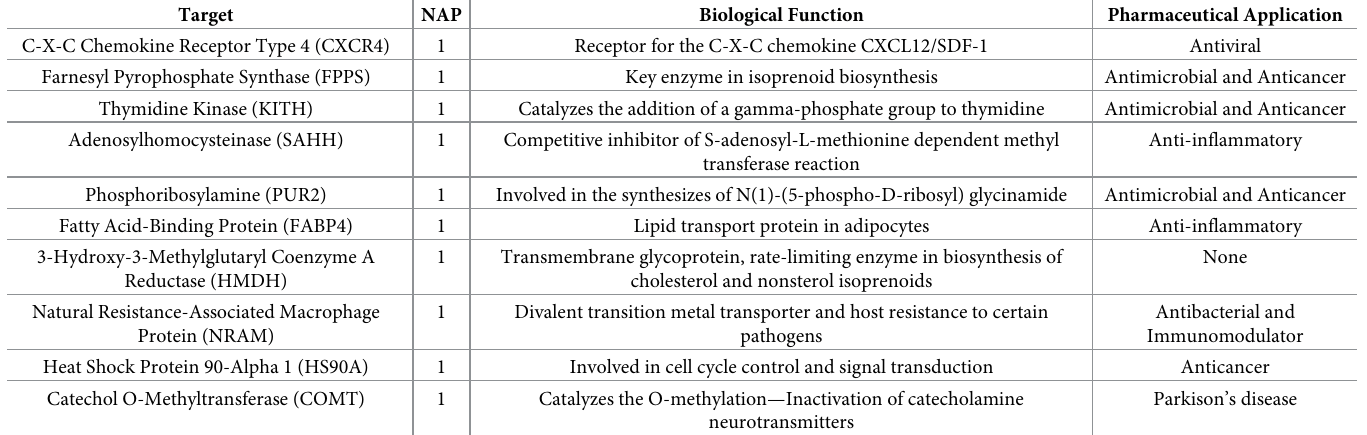
Table 1. Name, biological function and pharmaceutical application of best 10 performing targets with PharmaNet.